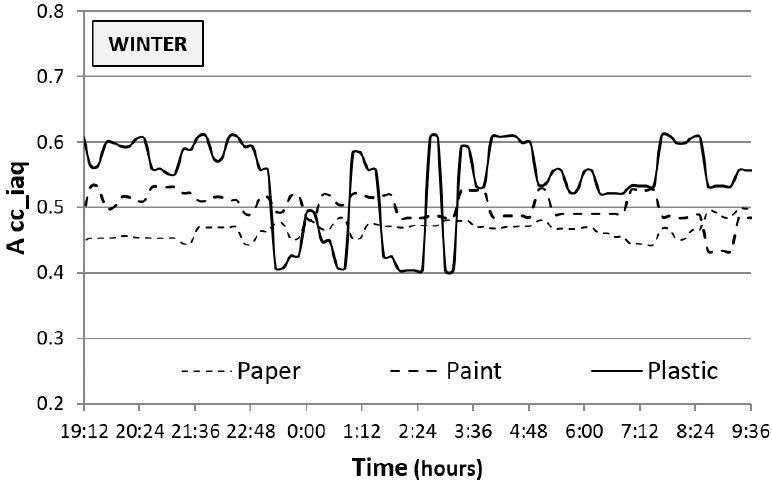
Figure 6. Indoor air acceptability (ACC IAQ ) predicted for each internal covering during the winter season.